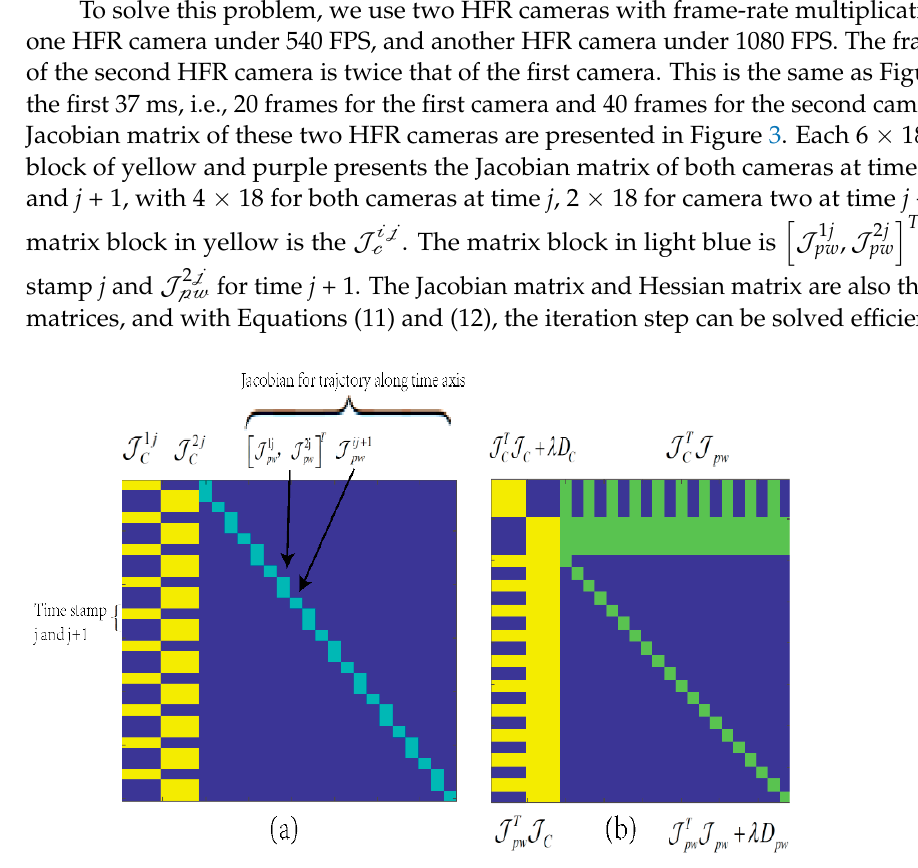
Figure 3. ( a ) Jacobian matrix for HFR cameras with frame-rate multiplication; ( b ) related Hessian matrix of these two HFR